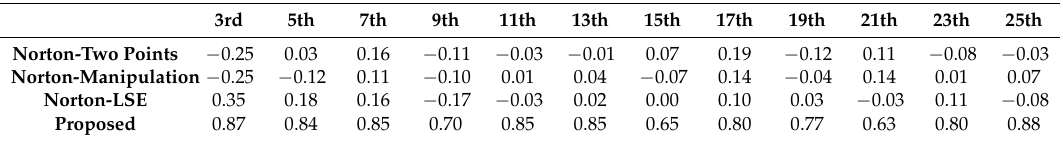
Table 8. Comparisons between the proposed method and Norton-based methods w.r.t. Correlation Coefficient.